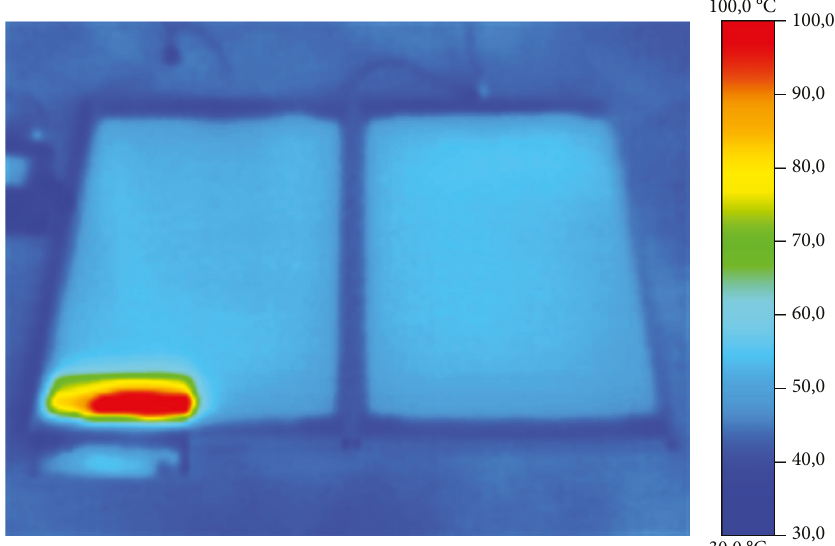
V = 11V ). 26 September 2017, Aversa (CE), Italy. S 1 ( PV = 25 ° C . amb